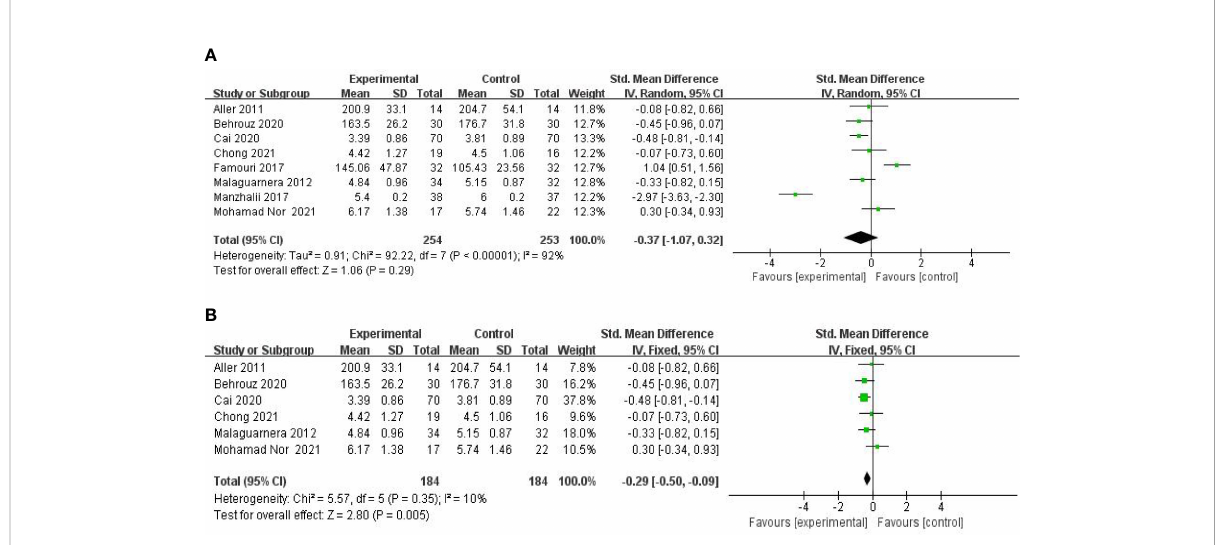
FIGURE 5 Forest plot of the effect of probiotic supplementation on TC (A) . Forest plot of the effect of probiotic supplementation on TC in the included studies with baseline BMIs of more than 27 kg/m2 (B)